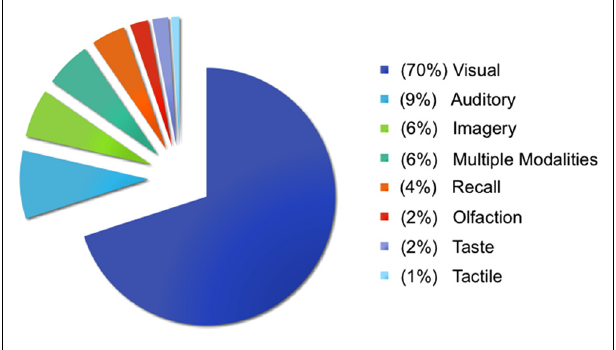
FIGURE 1 | Methods used to study emotion and affect. Visual methods typically involved viewing faces, pictures, films, words, sentences, and/or bodies. Auditory methods typically involved listening to voices, sounds, music, words, and/or sentences. Imagery methods typically involved generating imagery using personal memories, sentences, faces, and/or pictures (and are described further in the main text). Recall methods typically involved recalling personal events, words, films, or pictures.Tactile methods involved touch or thermal stimulation, olfaction methods involved smelling odors, and taste methods involved tasting food. Multiple modalities refers to studies that involved two or more of the aforementioned methods in the same study, with visual and auditory methods being the most frequent